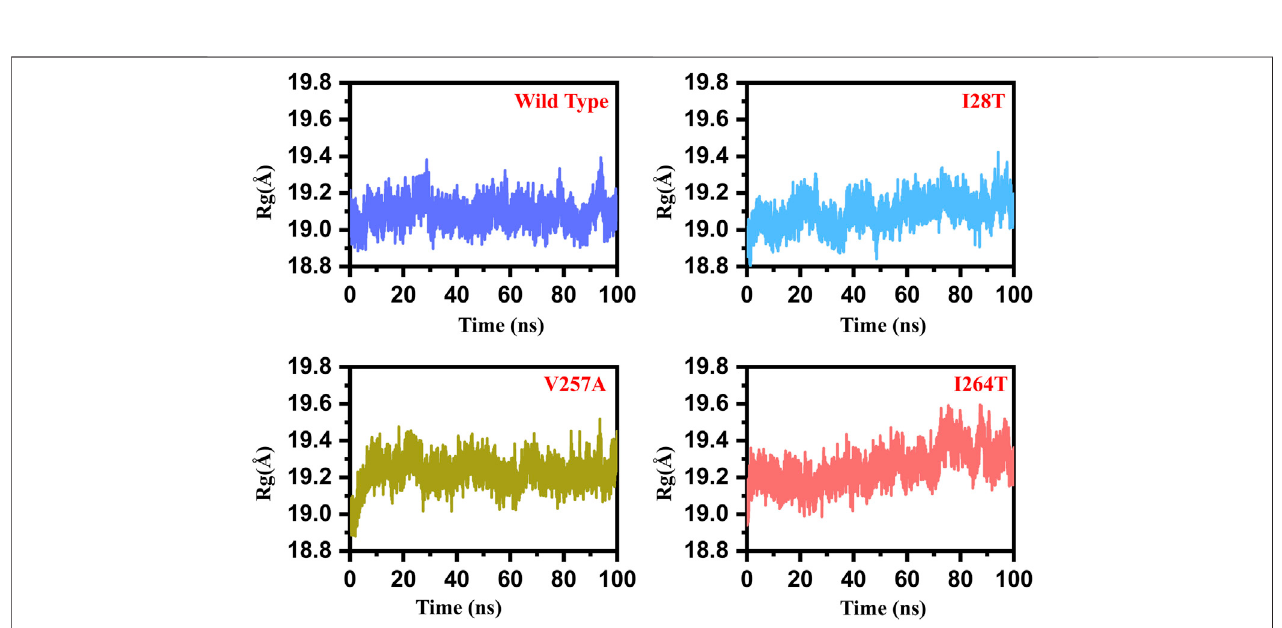
FIGURE7| RggraphoftheWTandmutants (I28T,V257A,andI264S).The x -axisshowsthetimeinnanoseconds,whilethe y -axisshows theRMSD inangstrom.